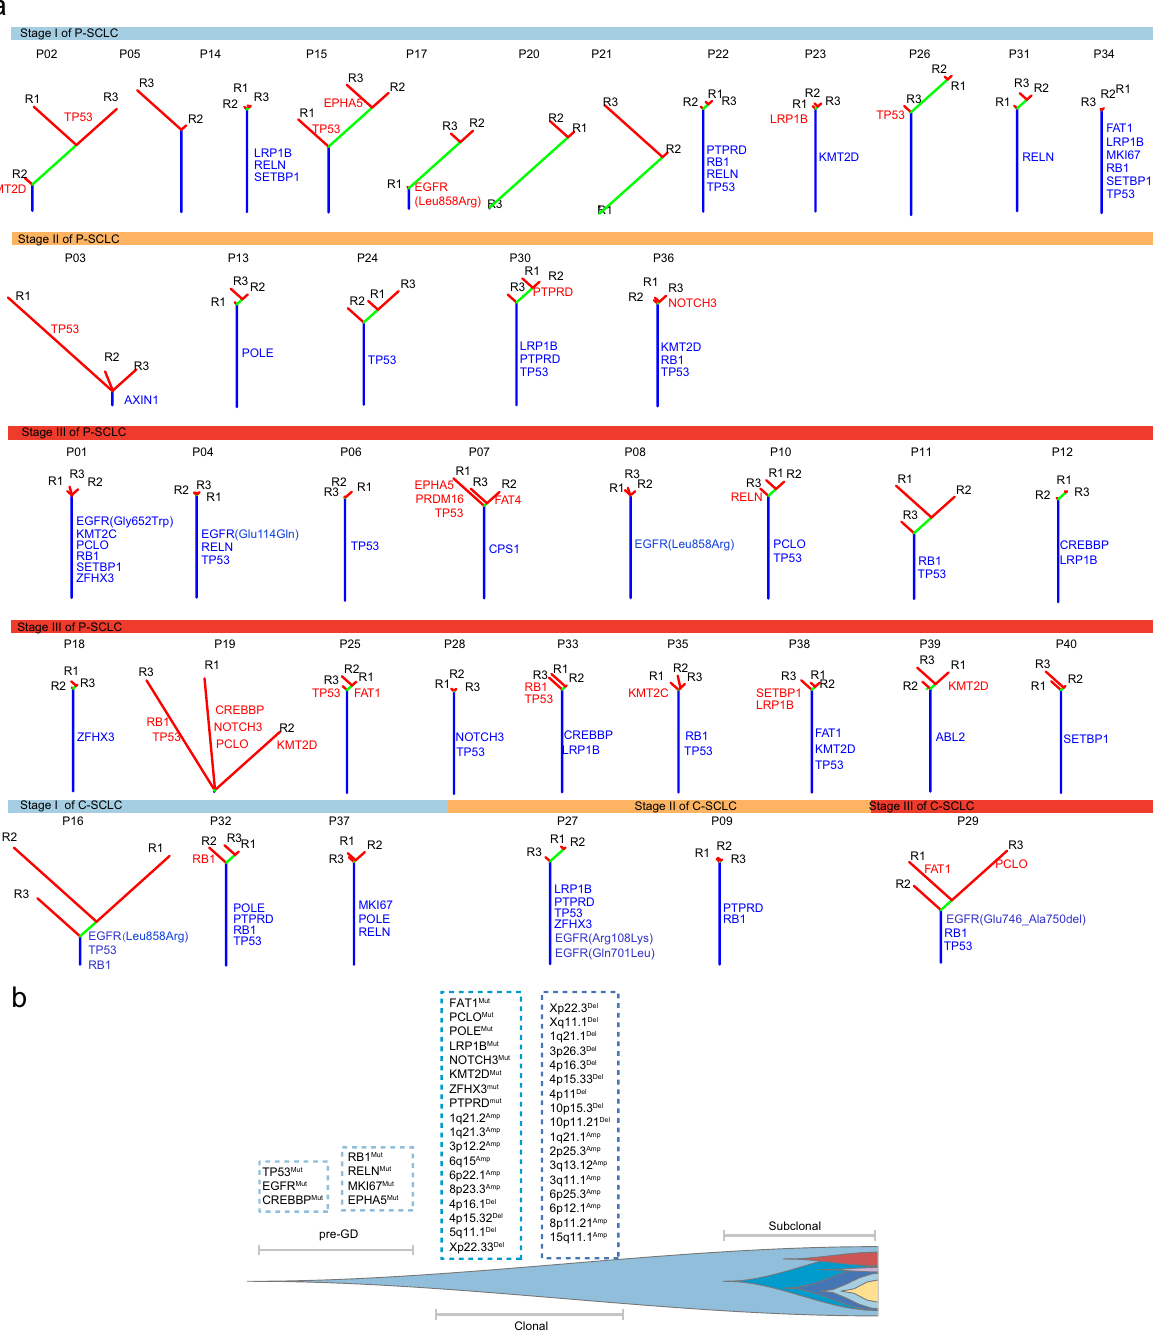
stage and tumor size), and genomic features (TMB, ITH, and smoker/non-smoker, EGFR mutant/wild type had similar levels of WGD) in SCLC (Supplementary Fig. 6a). Intriguingly, EGFR/ ITH, TMB, and mutation clusters, and they exhibited no RB1/TP53 -mutant patients exhibited higher ploidy than those discrepancy in their gene signature and mutation landscape with wild-type ( p = 0.017). And WGD occurred in all of the (Fig. 4, Supplementary Fig. 4b, c). Remarkably, a higher TMB/ EGFR/RB1/TP53 mutant patients (Supplementary Fig. 6a). cluster correlated with better DFS using univariate analysis, while Besides, these mutations were not associated with disease-free the SNV ITH was correlated to OS (Fig. 5b, c). However, no signi fi cant correlation was observed among DFS or OS and TMB, mutation cluster, or tumor stage (Fig. 5b, c, Supplementary Supplementary Fig. 3 and Fig. 5a show the basic clinicopatho- Fig. 6d, e). In a multivariate analysis adjusted for age, tumor size, logical information in this cohort. Patients with P-SCLC/C-SCLC, tumor stage, and smoking status, only TMB/cluster were NATURE COMMUNICATIONS| (2021) 12:5431